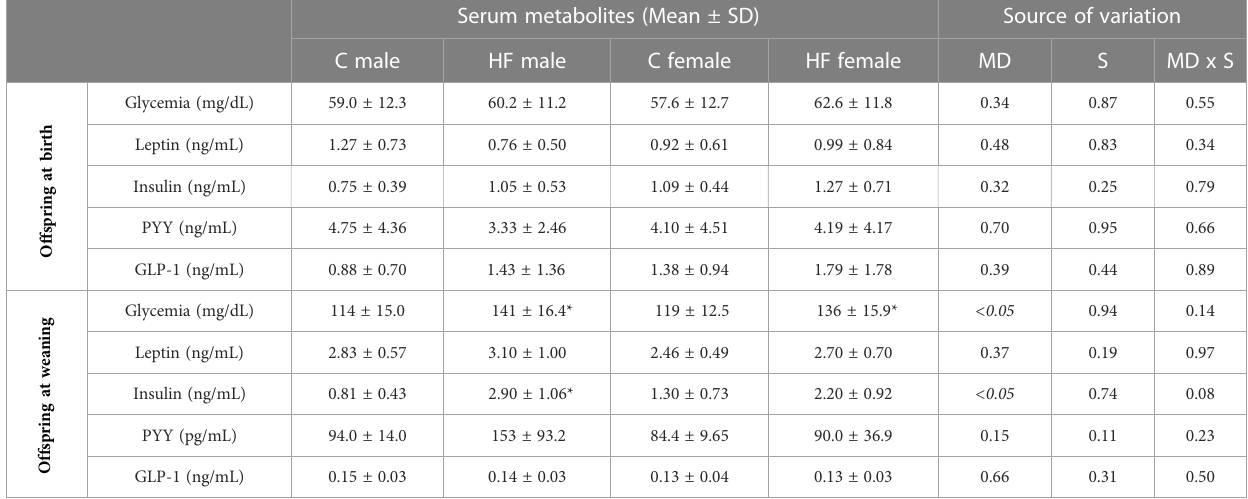
TABLE 3 Effect of maternal high-fat diet (HF) on serum metabolites of male and female offspring at birth and weaning. Serum metabolites (Mean ± SD)